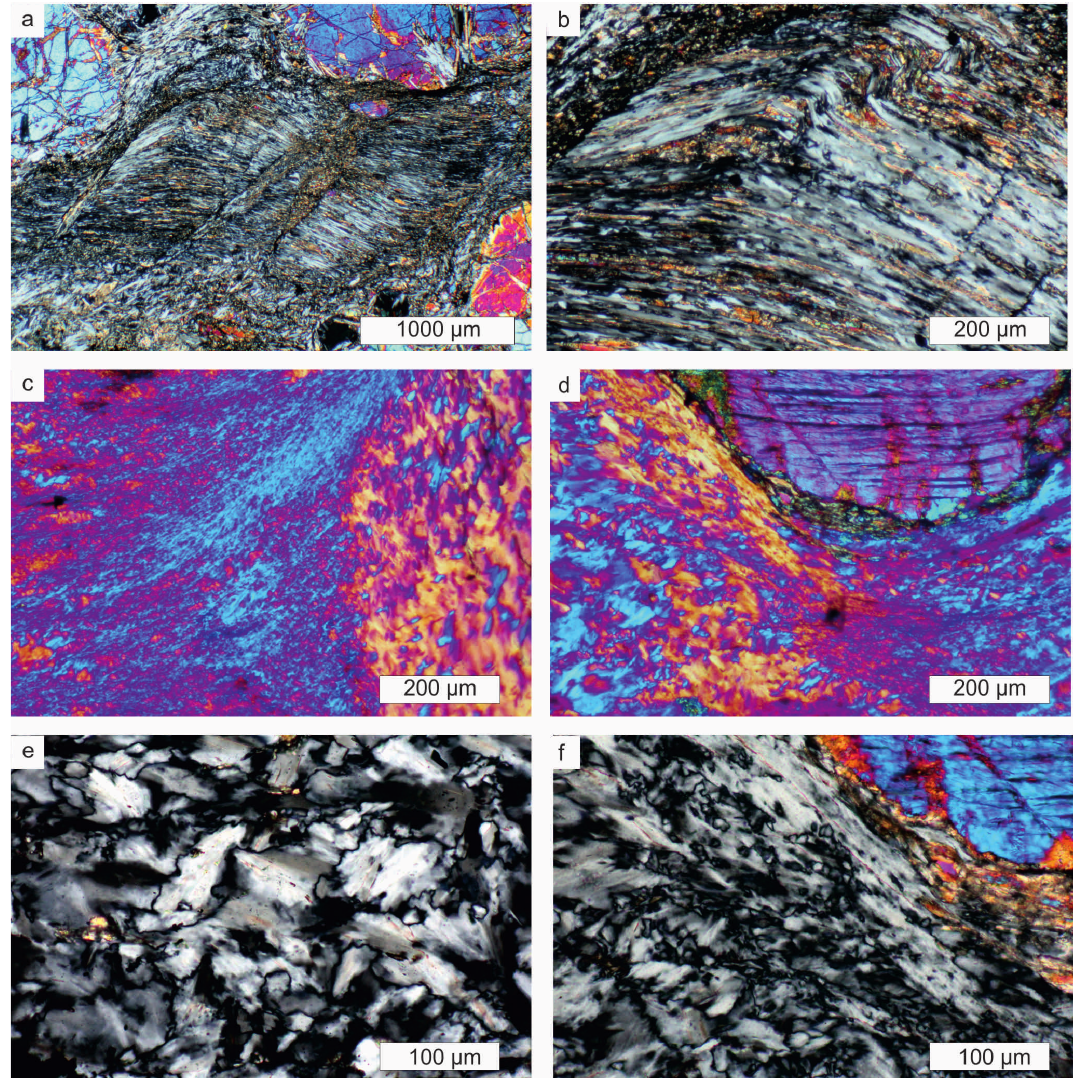
Fig. 8. Polarized light micrograph (crossed polarizers) showing antigorite microstructures. (a, b) Fine-grained folded antigorite (atg) layers forming a crenulation cleavage with fine-grained secondary olivine (ol) enriched in shear bands (sample CT_07-13). (c, d) Fine-grained antigorite aggregates (atg) with sutured grain boundaries, SPO and associated CPO deflected around porphyroclasts – photograph taken with λ -compensator plate inserted (sample CT_07-21). Note that the grain size of antigorite is very small at sites of stress concentrations. (e, f) Fine-grained antigorite aggregates with sutured grain boundaries (sample